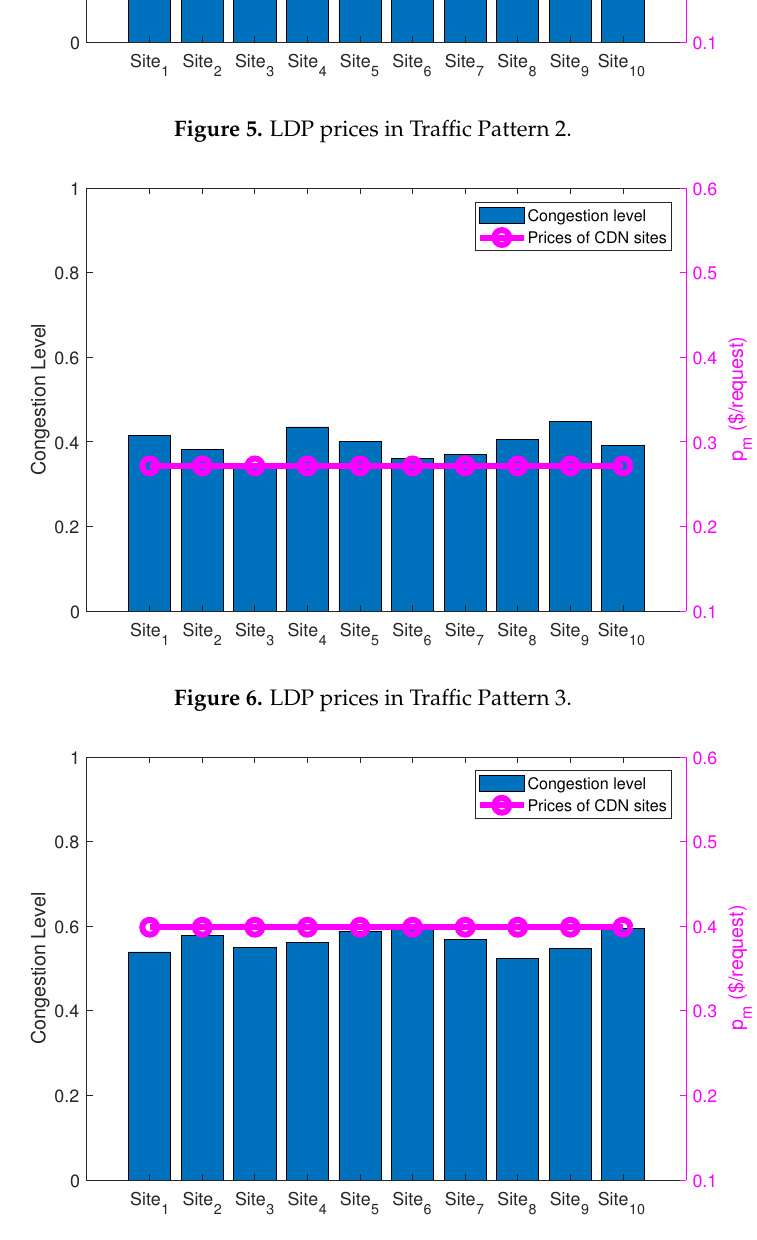
Figure 7. LDP prices in Traffic Pattern